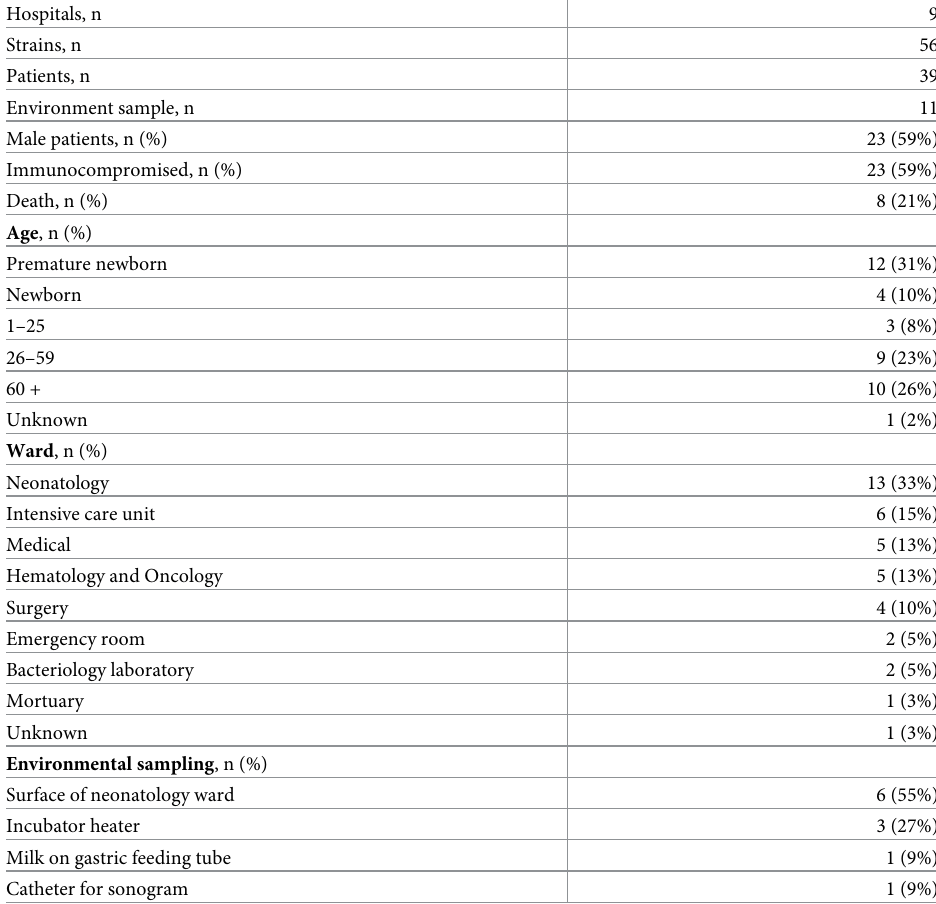
Table 1. Epidemiological and clinical data of patients and